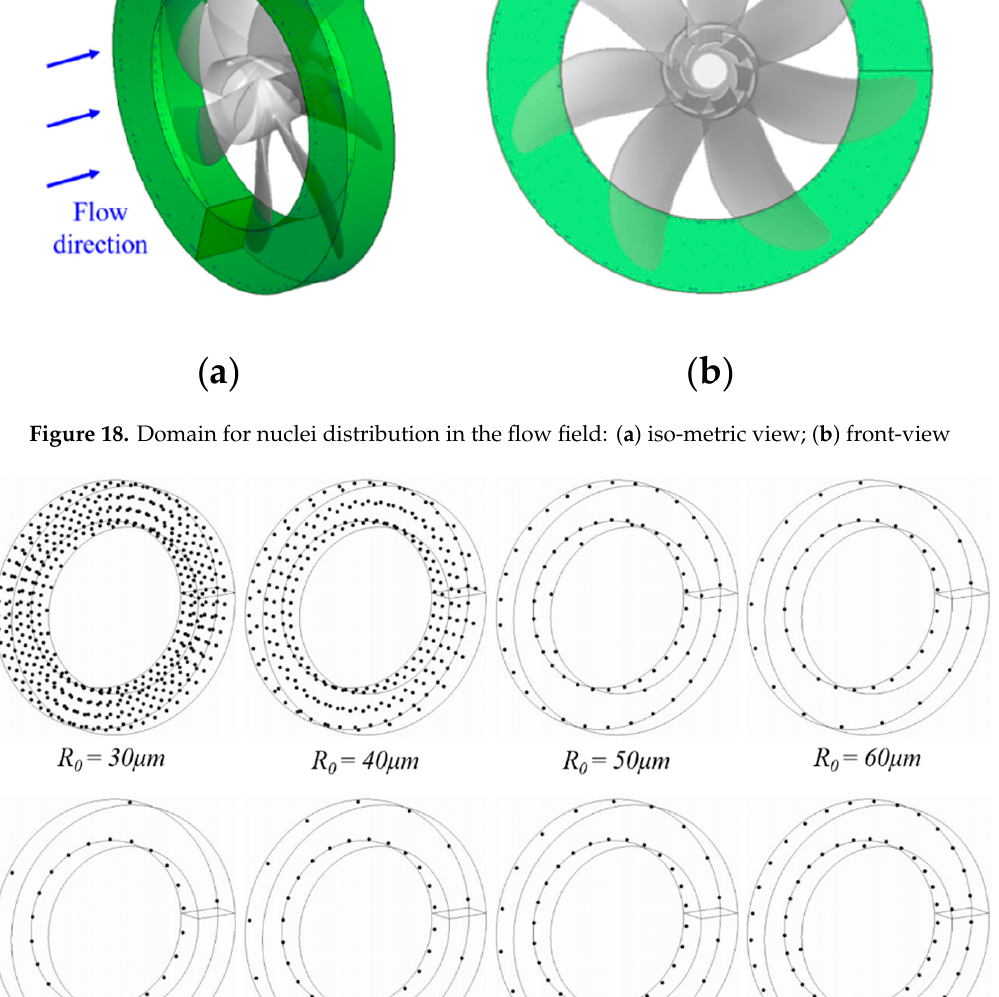
Figure 19. The distribution of each nuclei size.